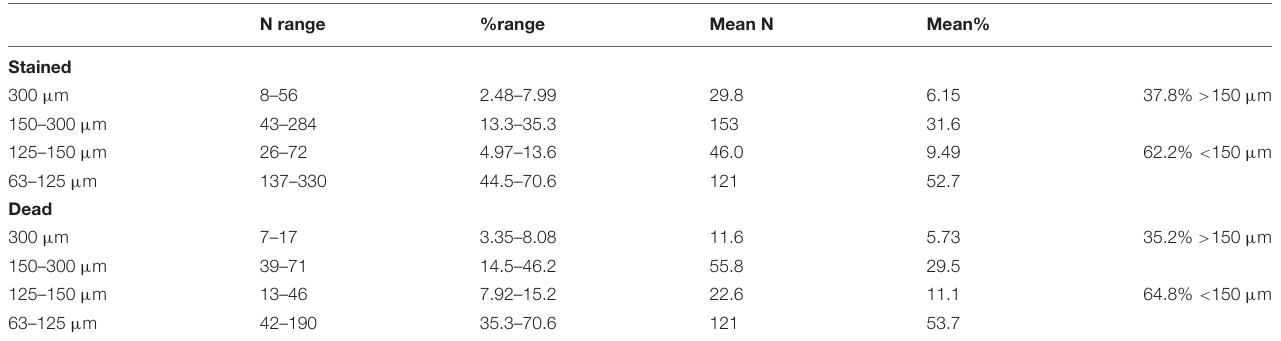
TABLE 1 | Numbers and percentages of complete foraminiferal tests (stained + dead) in the 5 sample splits of which the > 150 µ m and 63–150 µ m fractions were analyzed. N range %range